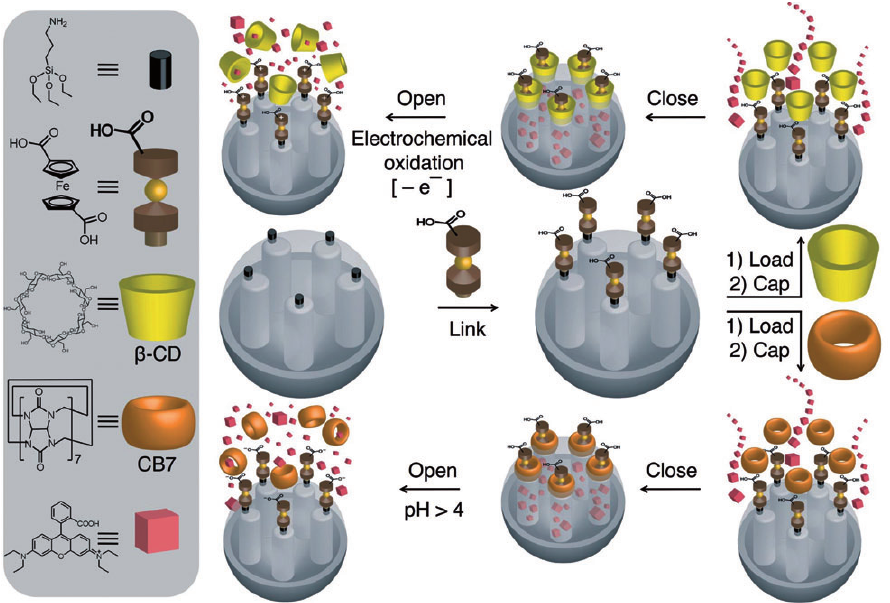
Figure 10 Design and preparation of FMNPs, which operate under redox or pH control according to the nature of the ring ( β -CD in the top route and CB7 in the bottom route) capping the pores [52]